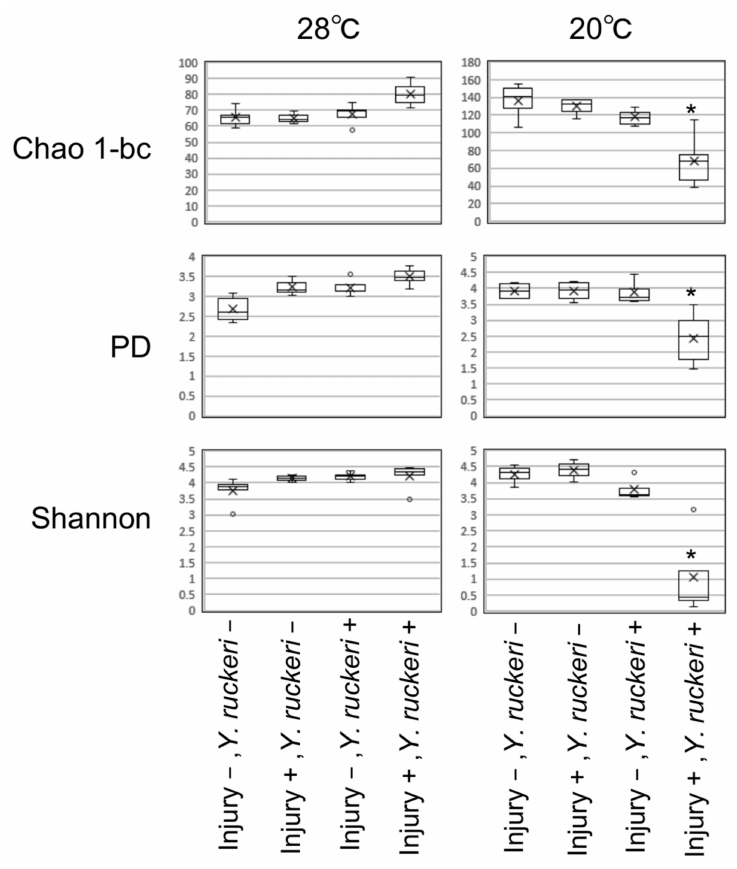
Figure 6. α -diversity of skin bacterial floras by injury and pathogen challenge at each temperature. The diversity indices, bias-corrected Cho1 estimator (Chao1-bc), phylogenetic diversity (PD), and Shannon diversity index (Shannon), were calculated by rarefaction analysis using 1500 reads selected randomly from each sample. Results from 3–5 individuals in each condition were represented by the box plot. *; p < 0.05 against a control group by Mann–Whitney U